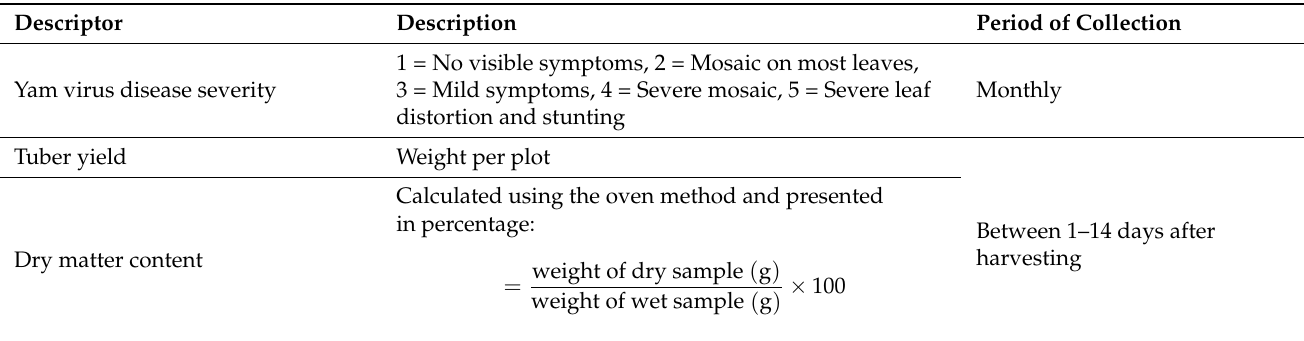
Table 3. Trait descriptors used for the evaluation of yam